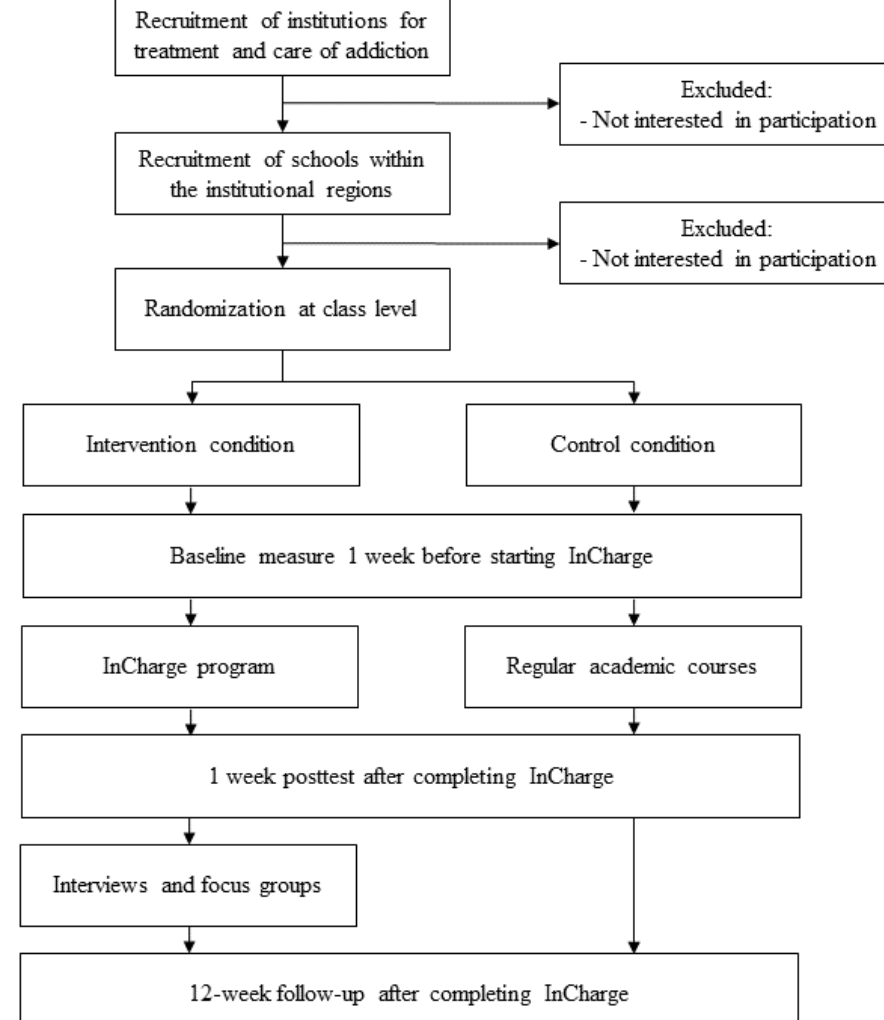
Figure 1. Design of the cluster randomized controlled